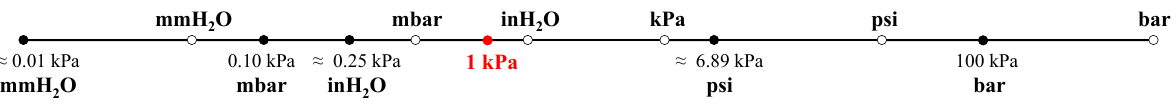
Figure 3. UOM conversion factors (full circles: absolute UOMs; empty circles: gauge UOMs).